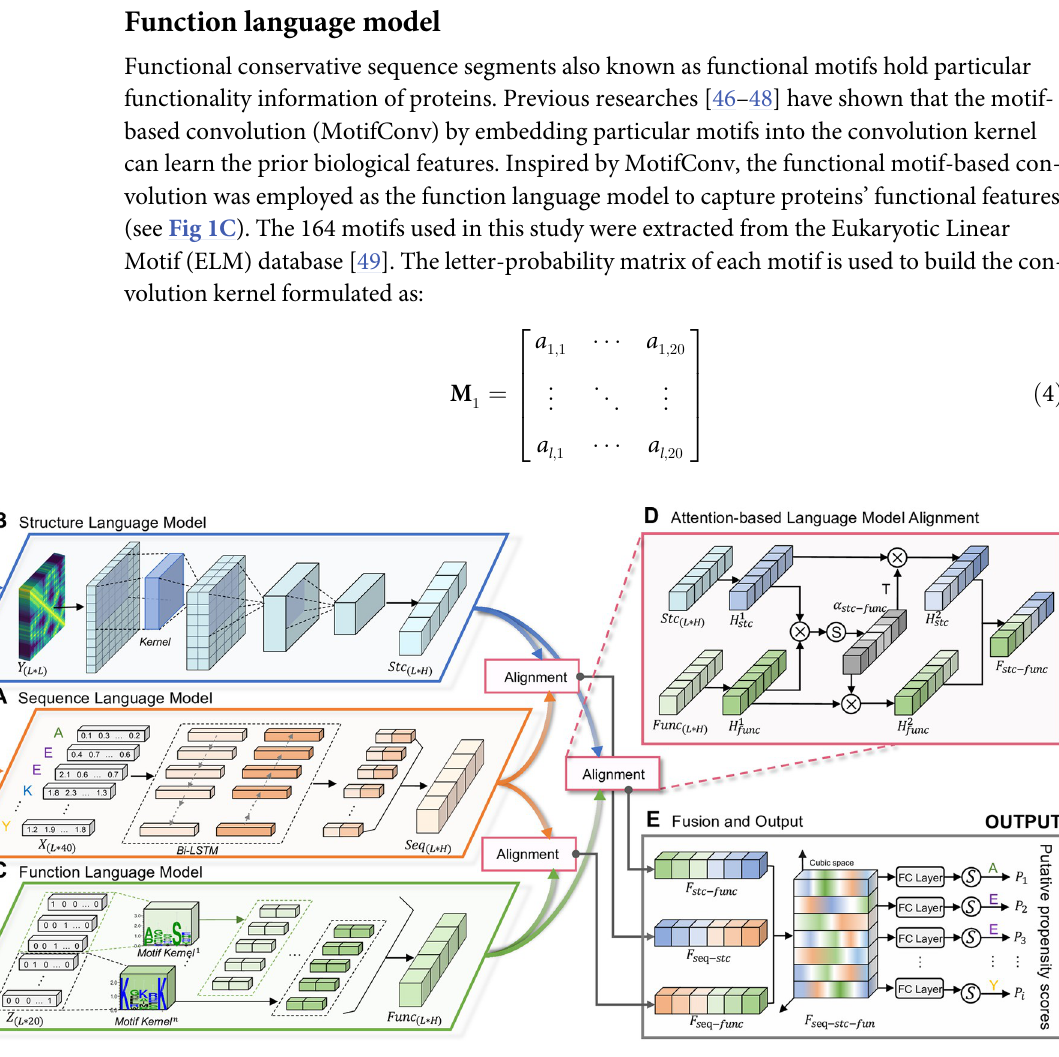
Fig 1. The architecture of protein cubic language model (PCLM). The PCLM contains five main modules: three protein language models ( A . sequence, B . structure, and C . function language model), attention-based language model alignment module ( D. ALAN), and the fusion and output layer ( E ). The input protein sequence is converted to sequence profile X , structure profile Y , and function profile Z , which are then fed into three protein language models to capture the sequence features Seq , the structure features Stc , and the function features Func . Next, three captured features are incorporated into the alignment features ( F stc−func , F seq−stc and F seq−func ) by ALAN modules. Finally, the fusion and output layers merge the outputs of ALAN to calculate the propensity score P i of disorder molecular function for each residue. https://doi.org/10.1371/journal.pcbi.1010668.g001 PLOS Computational Biology | https://doi.org/10.1371/journal.pcbi.1010668 October 31,